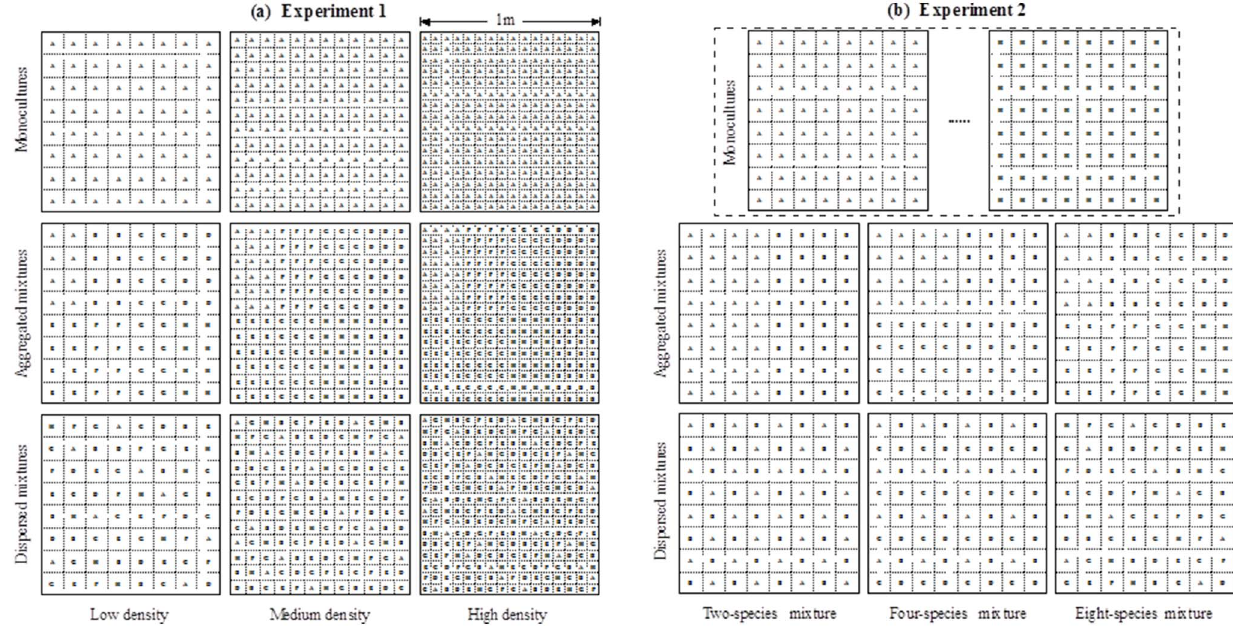
Figure 1. Experimental esign of the two experiments. ( a ) The first experiment comprised 9 blocks involving 8 species. Each block consisted of 36 plots (1 6 1 m in size). Illustrated here is one block but only shows 9 plots. The other 27 plots are not shown, including 21 monoculture plots for other 7 species (each being sown at low, medium and high density) and six mixcultures (i.e., the two spatial configurations for the 3 density levels, the same as the second and third rows). The aggregated and dispersed mixcultures both had the same 8 species but different spatial configurations. ( b ) The second experiment comprised 5 blocks involving 8 species. Each block consisted of 32 1 6 1 m plots. Illustrated here is one block but only shows 8 plots. The other 24 plots are not shown, including 6 monoculture plots for the other 6 species and 3 replicates for each of the six mixcultures (i.e., the two spatial configurations for the 3 diversity level). In both experiments, blocks were separated by 2 m walkways, and plots were separated 1 m